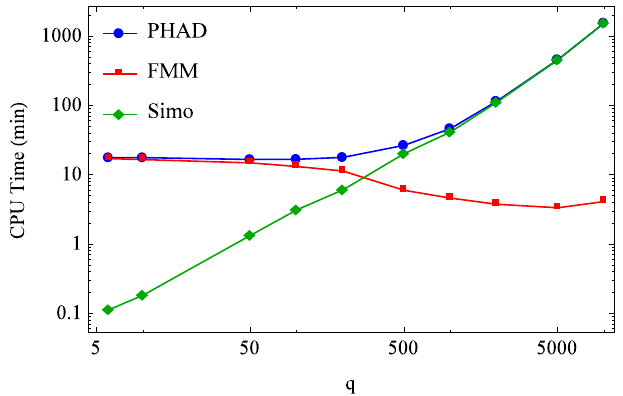
FIG. 7. Performance of PHAD as a function of the clustering parameter q for a Gaussian distribution of 10 5 electrons. The computationaltimeofPHADisprimarilycomposedofthecomputa- tional time of its FMM and the Simò integrator